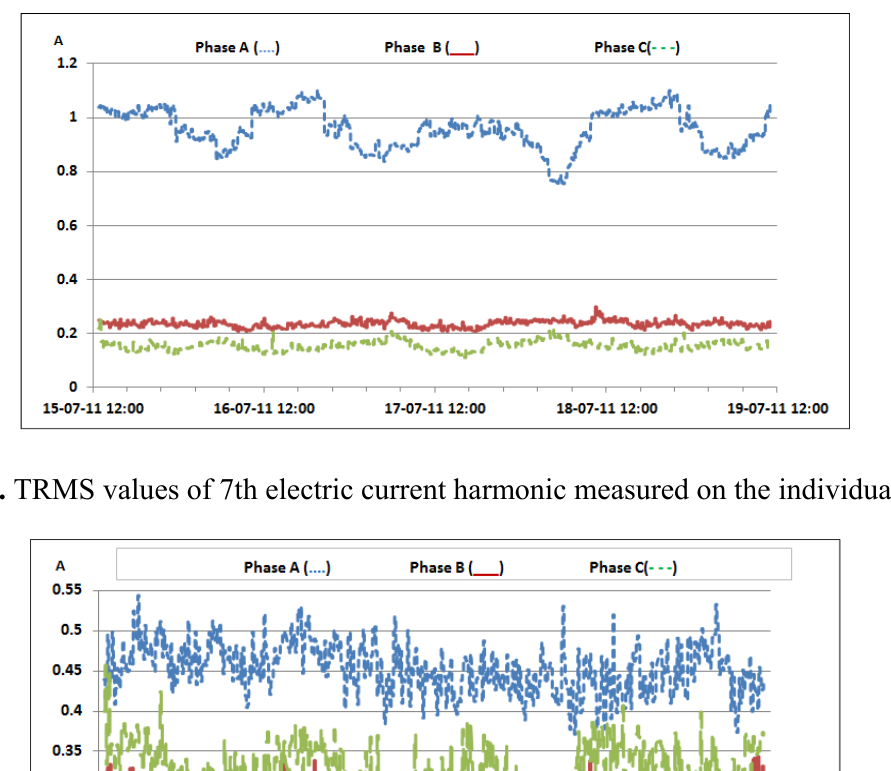
Figure 23. TRMS values of 5th electric current harmonic measured on the individual phases.